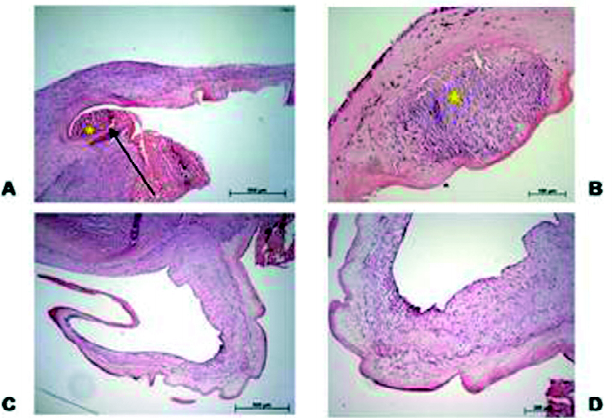
Fig.2 - Microscopia Óptica. A) Grupo L-Hydro: trombo em organização no Seio de Valsalva.B) Grupo controle: nódulos de maior celularidade. C) Grupo L-Hydro: Válvula com adelgaçamento progressivo em direção à borda livre, com celularidade escassa. D) Grupo L-Hydro: celularidade intersticial predomina nas regiões próximas ao anel e parece maior na metade voltada para a luz ventricular. Asteriscos mostram o local do trombo organizado (A) e local do nódulo de maior celularidade